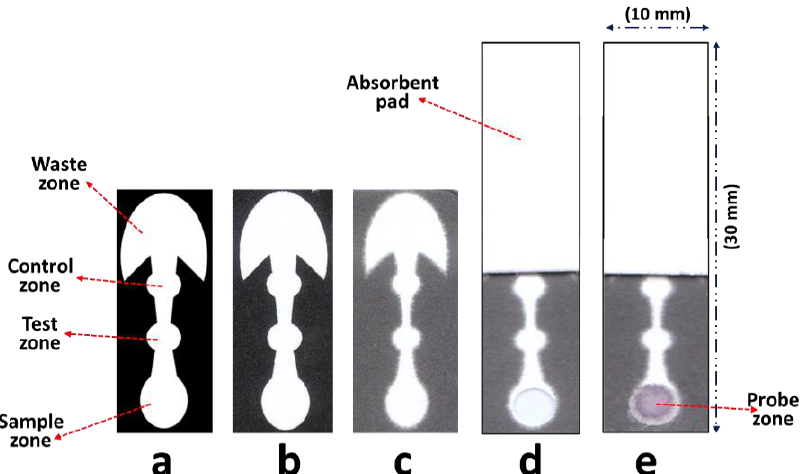
Figure 1. Fabrication process of µPADs. ( a ) Computer layout comprising detection, sample, and waste zones. ( b ) Printed pattern on the paper. ( c ) Melted wax. ( d ) Sample zone punched out and absorbent pad stacked on the waste zone. ( e ) Probe disk is stock on the sample zone.